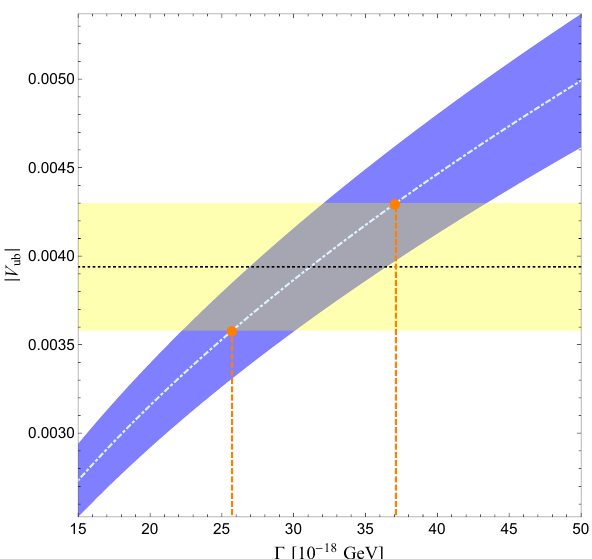
Figure 10 . The prospect for j V ub j determination from (cid:0)( B c ! D(cid:22) (cid:22) (cid:23) (cid:22) ); the yellow band represents the PDG value of j V ub j , eq.